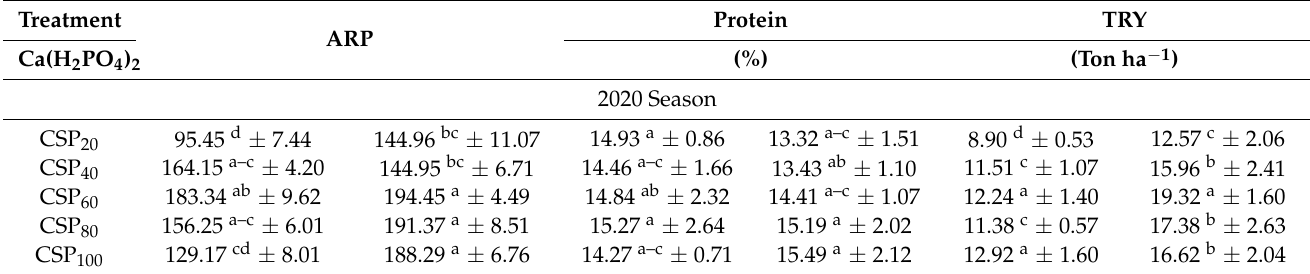
Mean values (± SE) with different letters in each column are significant ( p ≤ 0.05). CSP 20 , CSP 40 , CSP 60 , CSP 80 , and CSP 100 represent CSP added as a soil application at 69, 138, 207, 276, and 345 kg ha − 1 , respectively. DSM 0 = non-inoculated with Bacillus megaterium DSM 2894 var., DSM 1 = inoculated with Bacillus megaterium DSM 2894 var., ARP = Anti-radical power and TRY = Total roots yield.